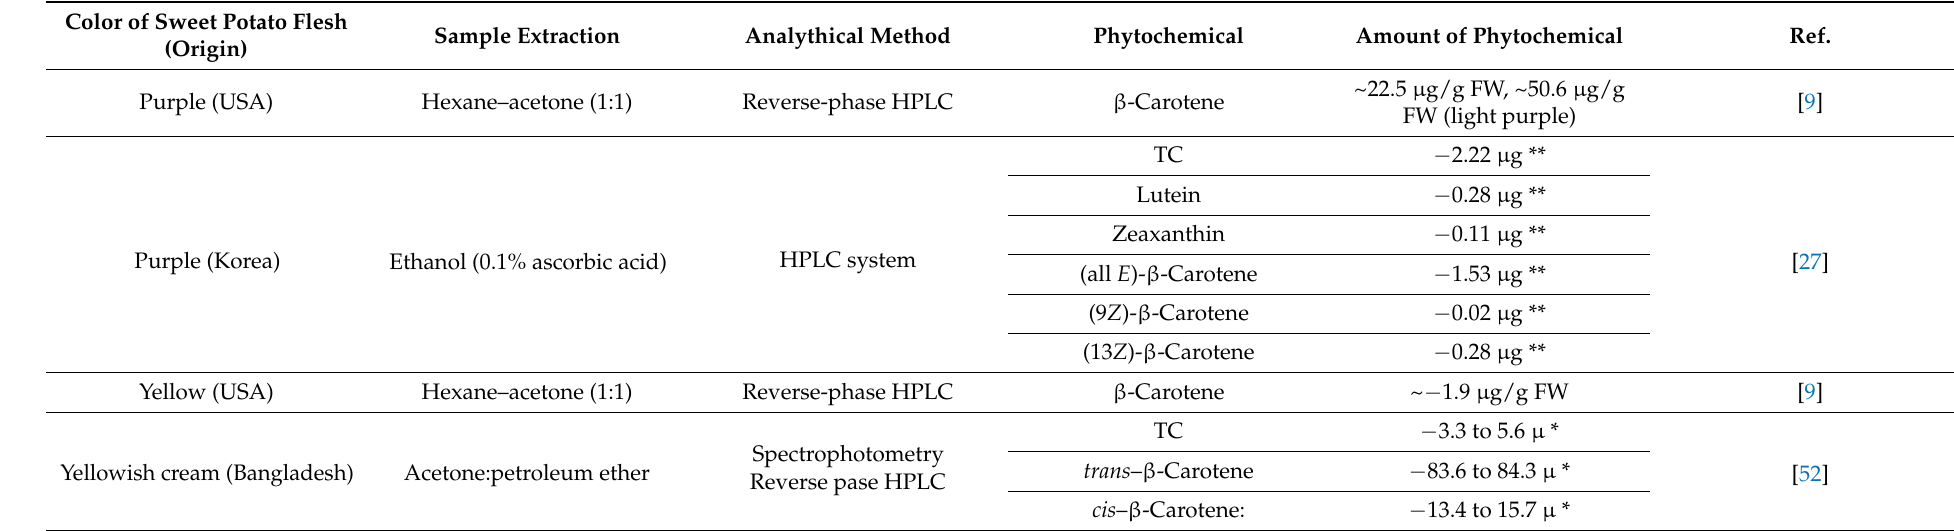
Table 5. Carotenoid content of purple, yellow, and white sweet potato